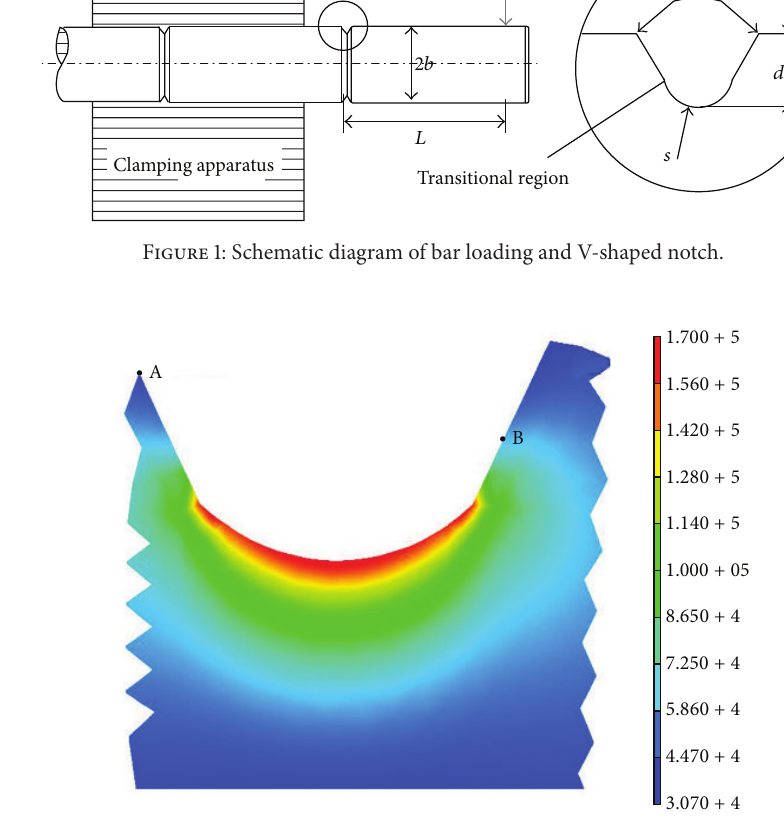
Figure 2: The equivalent stress nephogram near V-shaped notch